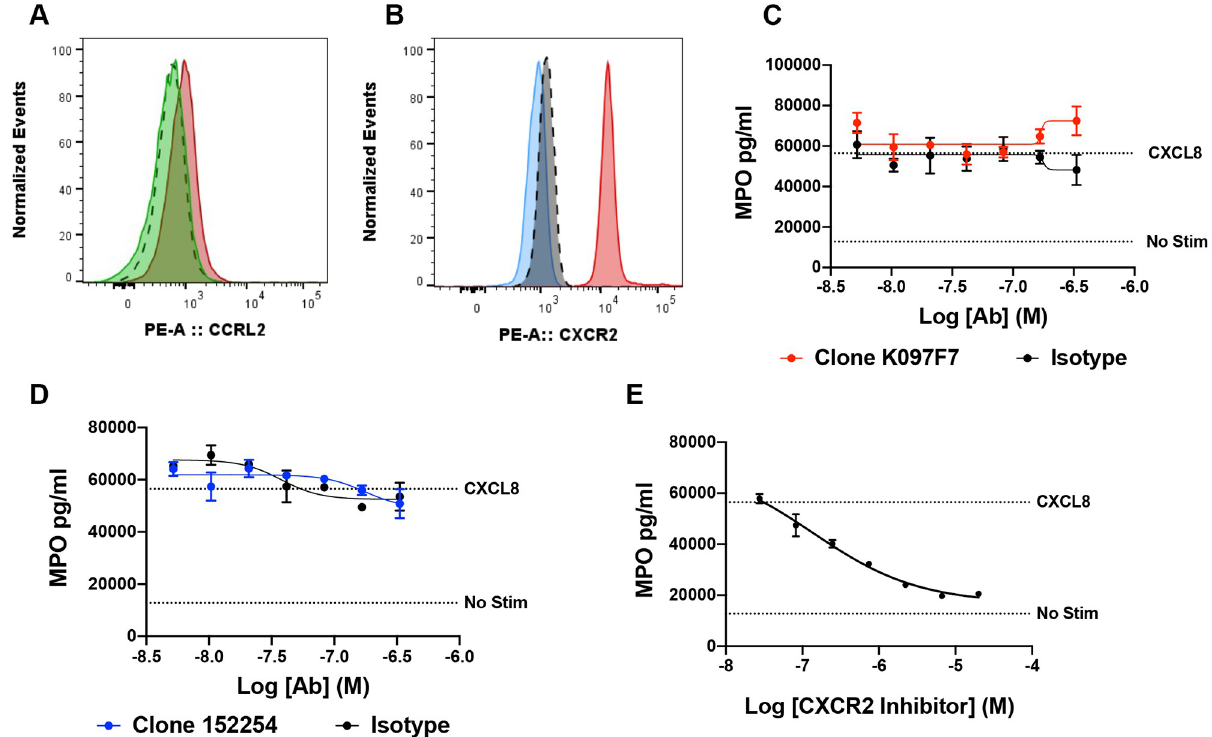
Fig 3. Effect of CCRL2 neutralization on primary human neutrophil degranulation. (A) Representative histogram quantifying CCRL2 expression on isolated primary human neutrophils using PE-conjugated K097F7 (red) and is representative of neutrophils profiled from 4 human donors. CCRL2 specific staining was determined by incubating neutrophils with unlabeled K097F7 prior to addition of PE-labelled K097F7 (green) and was compared to isotype control staining (black segmented). (B) Representative histogram of CXCR2 expression on isolated primary human neutrophils using PE- conjugated anti-CXCR2 (red) and is representative of neutrophils profiled from 3 human donors. CXCR2 staining was compared to PE-isotype control staining (grey dotted line) and unstained control (blue) neutrophils. (C-E) Degranulation of primary neutrophils. Primary neutrophils were pre- incubated with (C) K097F7, (D) 152254, or (E) the CXCR2 small molecule inhibitor SB225002, then stimulated with 100 ng/ml CXCL8. Supernatant concentrations of MPO were quantified by ELISA. (C-E) Shown are representative data from a single donor which are presented as Mean ± SEM (N = 2) (a total of 3 different neutrophil donors were tested